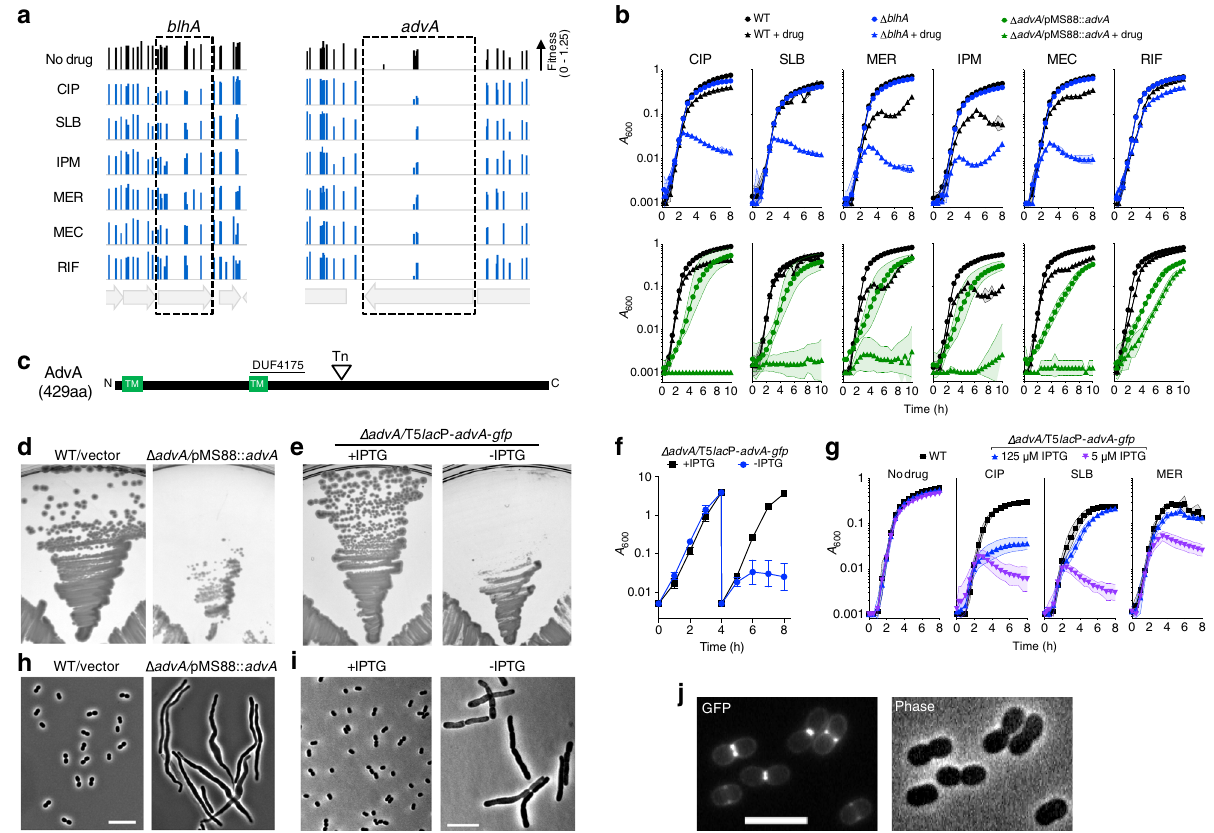
Fig. 3 AdvA is a critical cell division protein connected by susceptibility phenotypes to BlhA. a A. baumannii transposon mutants mapping throughout blhA and in a limited region of advA show decreased fi tness with fl uoroquinolones and β -lactams but not RIF. Bars show Tn-seq fi tness values of individual Tn 10 mutants at each locus across all tested banks in the indicated condition. b Validation of Tn-seq drug susceptibility phenotypes using de fi ned mutants independently cultured in microplates. EGA746 ( Δ blhA , top, blue symbols) or EGA745 ( Δ advA /pMS88:: advA , bottom, green symbols) were tested in parallel with the same WT control (black symbols). Data are presented as geometric mean (indicated by symbols) ±s.d. (indicated by area- fi lled dotted bands) from n = 3 independent cultures. Where not visible, s.d. is within the con fi nes of the symbol. c Schematic of AdvA protein. Tn indicates approximate location of transposons in advA analyzed by Tn-seq, TM indicates predicted transmembrane helix. d , e AdvA is essential for colony formation. EGA745 or control were grown on solid medium at 37 °C ( d ). AFA11 ( Δ advA harboring T5 lac P- advA - gfp ) was grown on solid medium ± 0.5 mM IPTG ( e ). Images are representative of 18 ( d ) or 3 ( e ) parallel cultures. f AdvA is essential for growth in broth. AFA11 pregrown with 1 mM IPTG was diluted into LB ± 1 mM IPTG, followed by dilution into the same medium after 4 h. Growth was monitored by A 600 (1-cm cuvettes). Data points show geometric mean ± s.d. ( n = 3 independent cultures). g AdvA level determines antibiotic susceptibility. AFA11 pregrown with 250 µ M IPTG was washed, resuspended in LB with 5 or 125 µ M IPTG, and cultured with WT control in microplates with or without the indicated sub-MIC antibiotic (Supplementary Table 1). Data are shown as geometric mean ± s.d. as in ( b ). h , i advA de fi ciency results in cell fi lamentation. The indicated strains grownwith or without inducer were imaged via phase-contrast. Images are representative of three parallel cultures. Scale bar, 10 µ m. j AdvA-GFP localizes to mid-cell at sites of cell division. WT A. baumannii harboring T5 lac P- advA - gfp was cultured to mid-log phase with 50 µ M IPTG and imaged by phase-contrast and fl uorescence microscopy. Scale bar, 5 µ m. Images are representative of two parallel cultures. Source data are provided as a Source Data fi